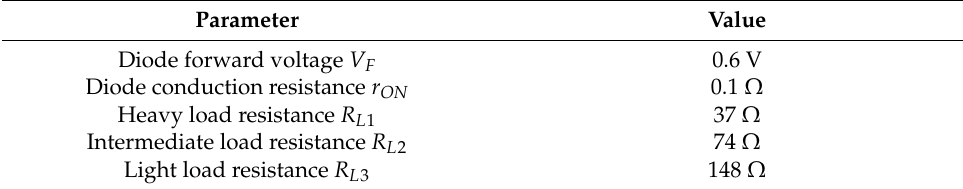
Table 4. Converters’ operating